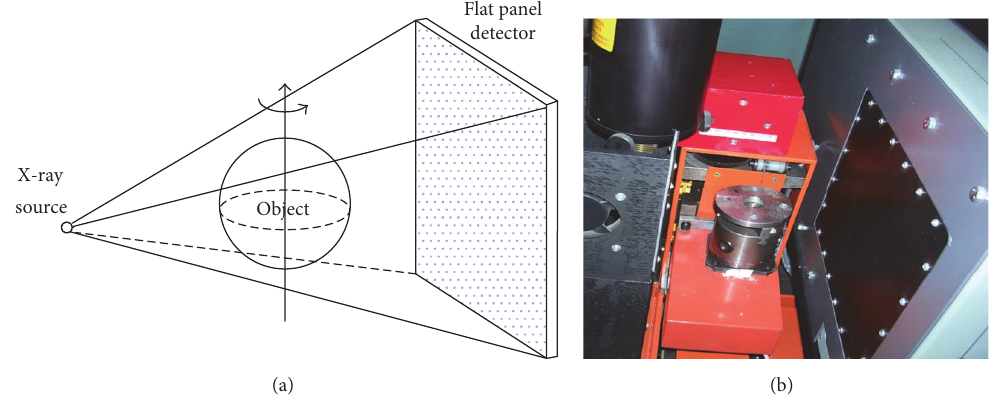
Figure 4: Scheme of flat panel based 3D cone-beam CT system and